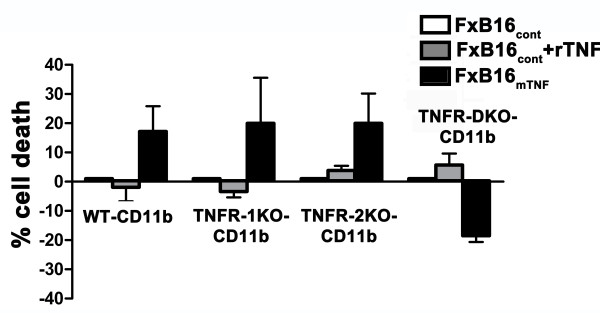
Membrane TNF-induced cell death can be mediated through both TNFR-1 and TNFR-2. Freshly isolated CD11b myeloid cells from wild type mice (WT-CD11b), mice deficient in TNF receptor 1 (TNFR-1KO-CD11b), TNFR-2KO-CD11b or both receptors (TNFR-DKO-CD11b). Cells were cocultured with paraformaldehyde-fixed control (FxB16cont), control in the presence of 100 U/ml recombinant TNFα (FxB16cont + rTNF), or mTNFα (FxB16mTNF) for 24 hours. Percentage of cell death was measured by MTT assay. Data present mean percentage (bars, mean ± S.E.) of three replicates from 3 independent experiments.